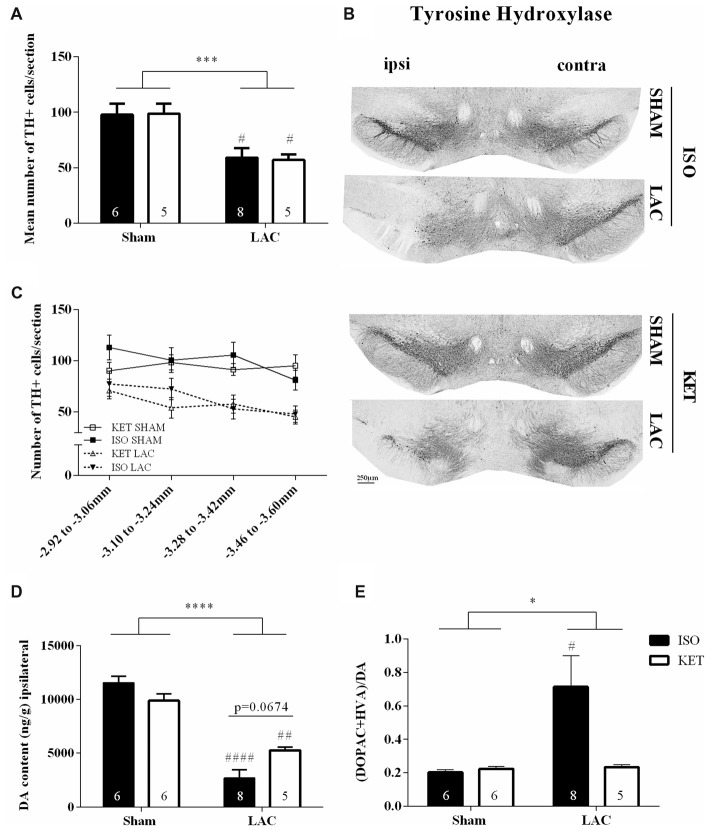
Influence of anesthetics on nigrostriatal degeneration. Ipsilateral effects of LAC-infusion on the mean number of dopaminergic cells (TH+ cells) per section in the Substantia nigra pars compacta (SNpc; A), striatal DA content (D) and DA turnover (E) of mice anesthetized with ISO or KET during stereotaxic surgery. For all parameters, a significant global effect of LAC lesion was present in both anesthetized groups compared to sham-lesion. At the level of the striatum, DA depletion was more pronounced in mice anesthetized with ISO (ISO LAC) compared to KET (KET LAC; borderline significance; D). An increased turnover of DA was detected in mice receiving an intranigral LAC injection under ISO anesthesia compared to sham treatment (E). Sample size is indicated in the graph. Bars represent mean ± SEM. *p < 0.05; ***p < 0.01; ****p < 0.0001 (global lesion effect, two-way ANOVA), #p < 0.05, ##p < 0.01, ####p < 0.0001 (Tukey’s post hoc test vs. corresponding sham-lesioned group). Representative TH photomicrographs of the SNpc in the four experimental groups (B). Rostro-caudal distribution of the number of TH+ cells per section, showing a similar distribution of cell loss after LAC in the ISO and KET groups (C). DA, dopamine; ISO, isoflurane; KET, ketamine; LAC, lactacystin; TH, tyrosine hydroxylase.